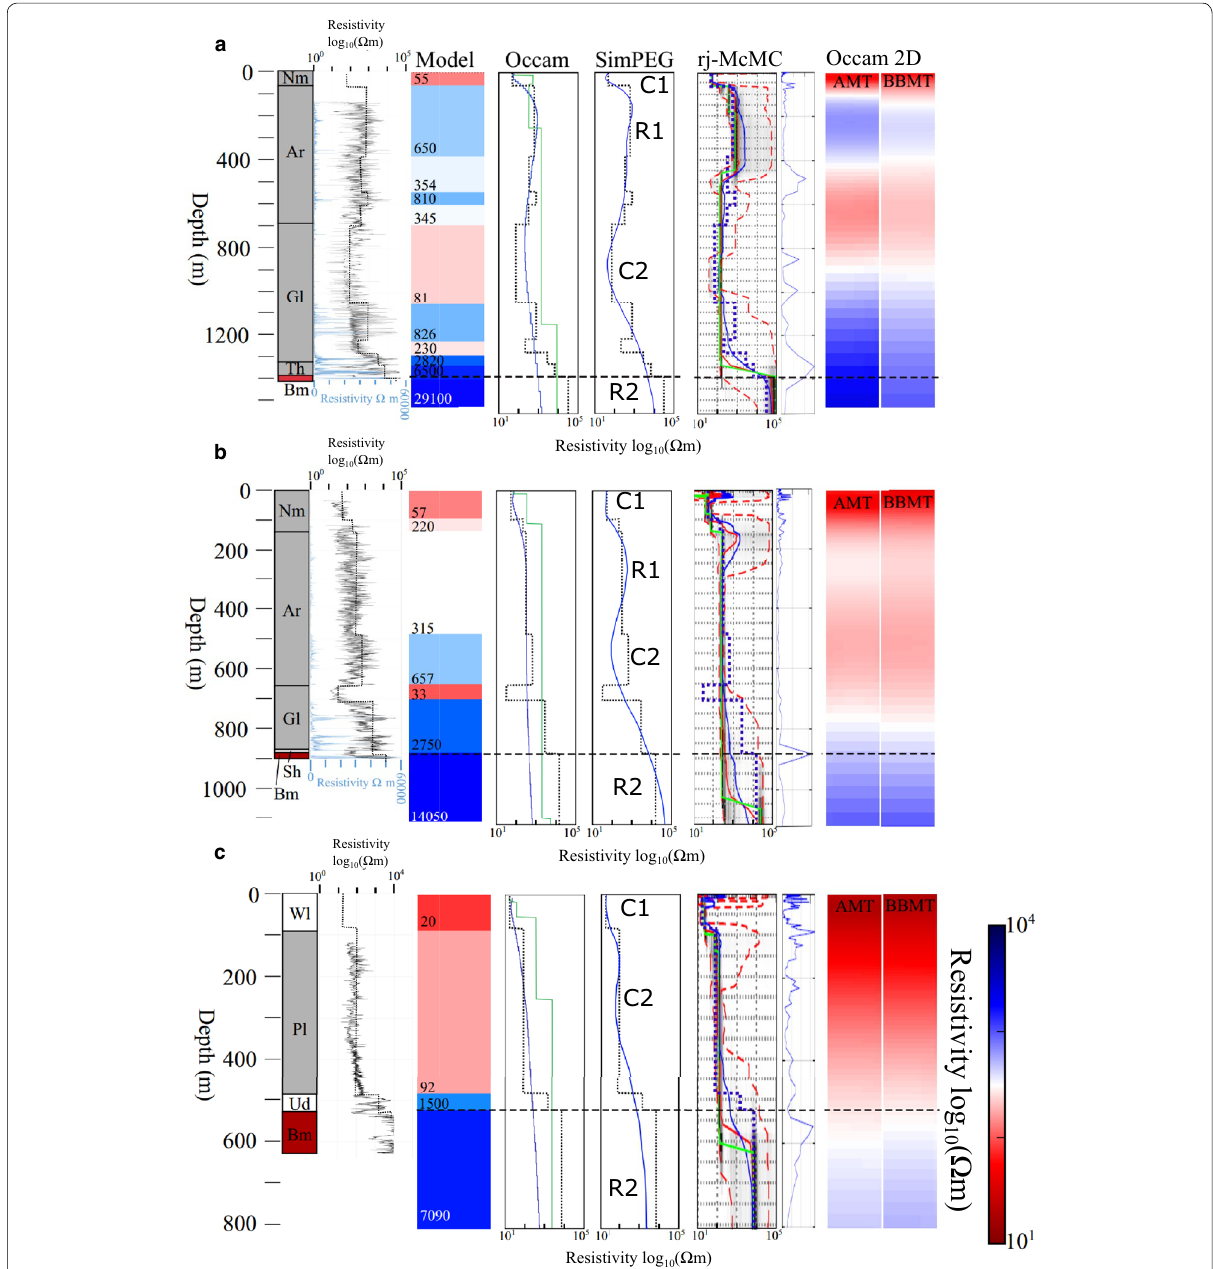
Fig. 5 Summary of synthetic modelling conducted using downhole resistivity from petroleum wells. a Todd 1 (Kress and Simeone 1993), b Bradley 1 (Kress 1989), and c Beantree 1 (Green et al. 1963). From left to right for: downhole logged geology, limestone units in grey, siliciclastic units in white and basement in red; measured downhole resistivity, black logarithmic scale, blue linear scale, dashed line represents the averaged resistivity used to create the 1D model; 1D synthetic model created from downhole resistivity data, annotated with resistivity (Ωm), basement interface indicated with black dashed line; results from Occam1D inversion, model in thick dashed line, minimum layer model green, n blue; 1D MT SimPEG inversion, model in dashed line, inverted response in blue, major resistivity packages annotated; rj-McMC MT inversion with automatically generated changepoint probability; Occam 2D inversion results for BBMT and AMT frequency ranges. Colour scale applies to all plots, including models. Gl Georgina Limestone, Bm basement, Ar Arrinthrunga Formation, Nm Nimaroo Formation, Sh Sun Hill Arkose, Pl Pomegranate Limestone, Ud Undifferentiated, Ar Arrinthrunga Formation, Wl Wilgunya Subgroup, Nm Nimaroo Formation, Th Thorntonia